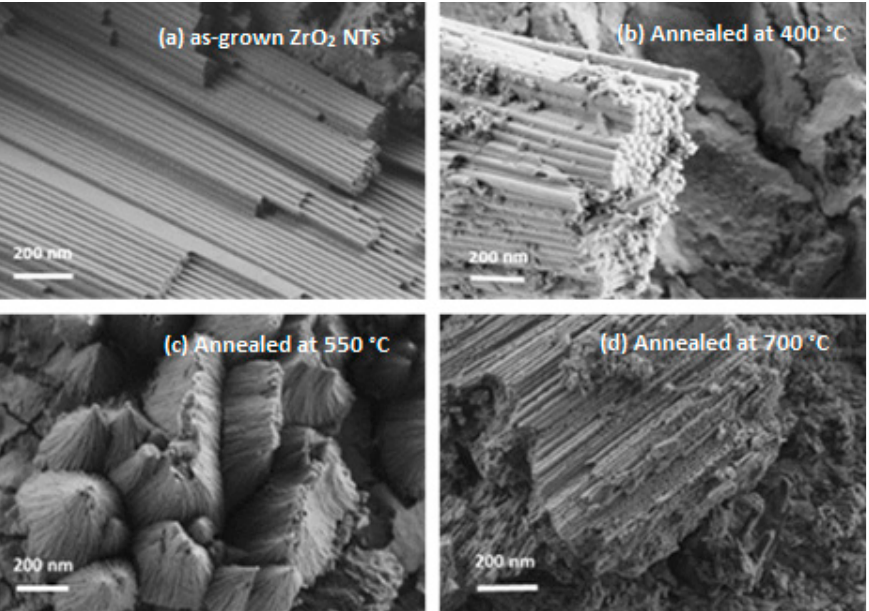
Figure 1. SEM images of ( a ) as-grown zirconia nanotubes and ( b – d ) after air annealing at different temperatures (400 °C, 550 °C, and 700 °C, respectively).